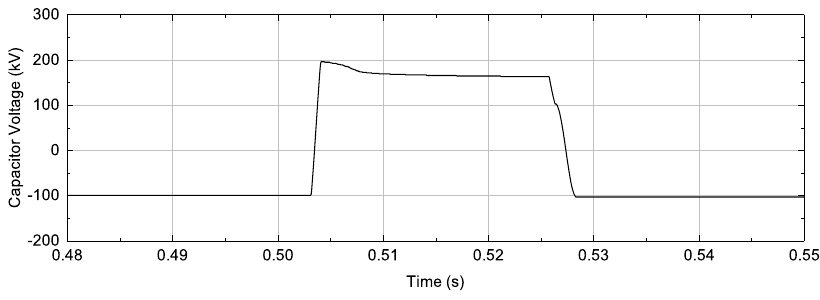
Figure 11. Overall currents on the switches of HCB 4.